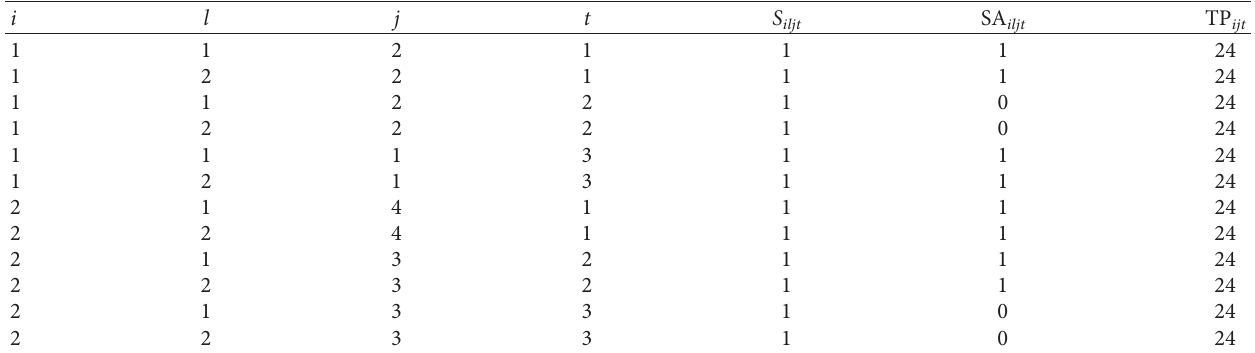
Table 9: Small dataset results of the base LSSP MILP: scheduling.